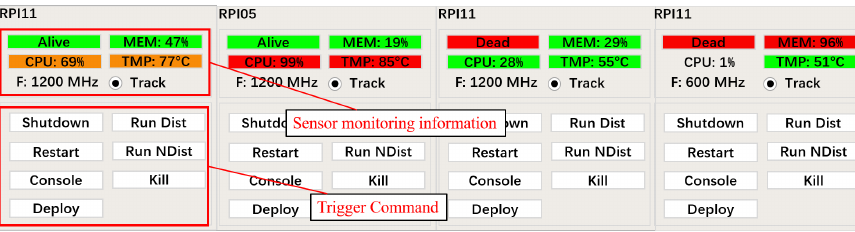
Figure 11. Control interface: sensor monitoring and trigger